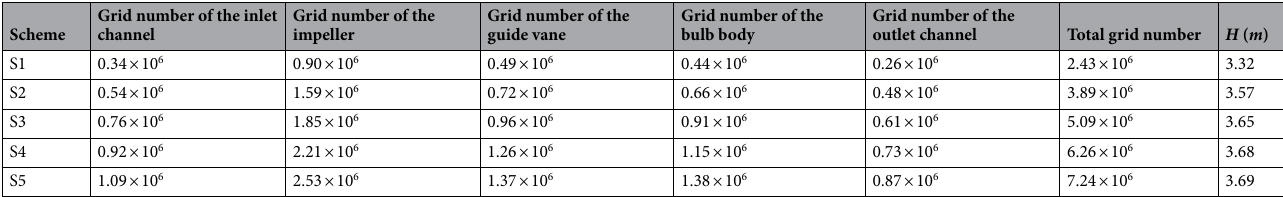
Table 2. Grid independence test.